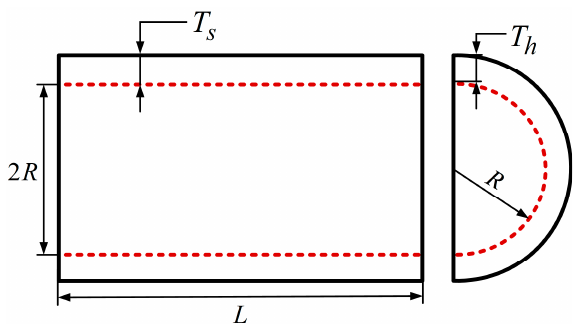
Figure 11. Schematic illustration of pressure vessel design problem.